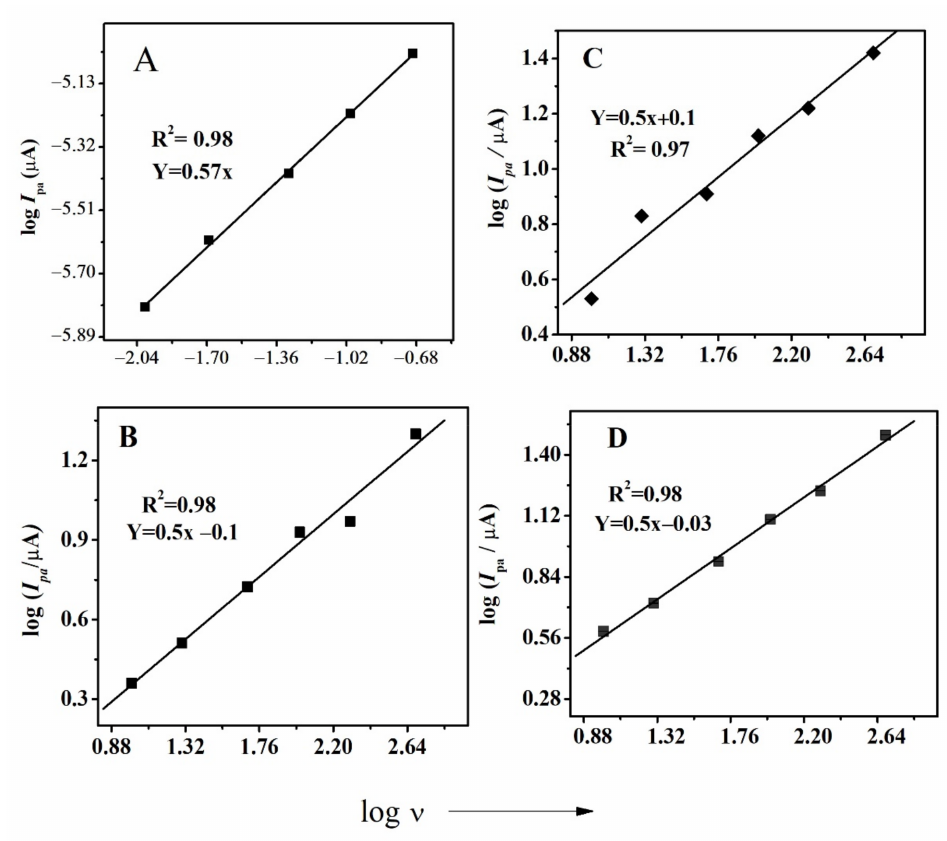
Figure 3. Plot of log I pa vs. log ν for ( A ) FBA ( B ) FA ( C ) CFA ( D )